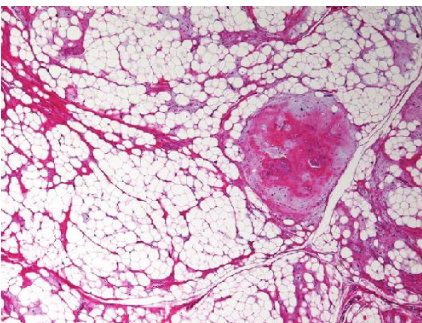
Figure 1: Case 1. Lipoma with chondroid di ff erentiation. Area of mature cartilage nodule is surrounded by normal adipose tissue (HE, original magnification ×